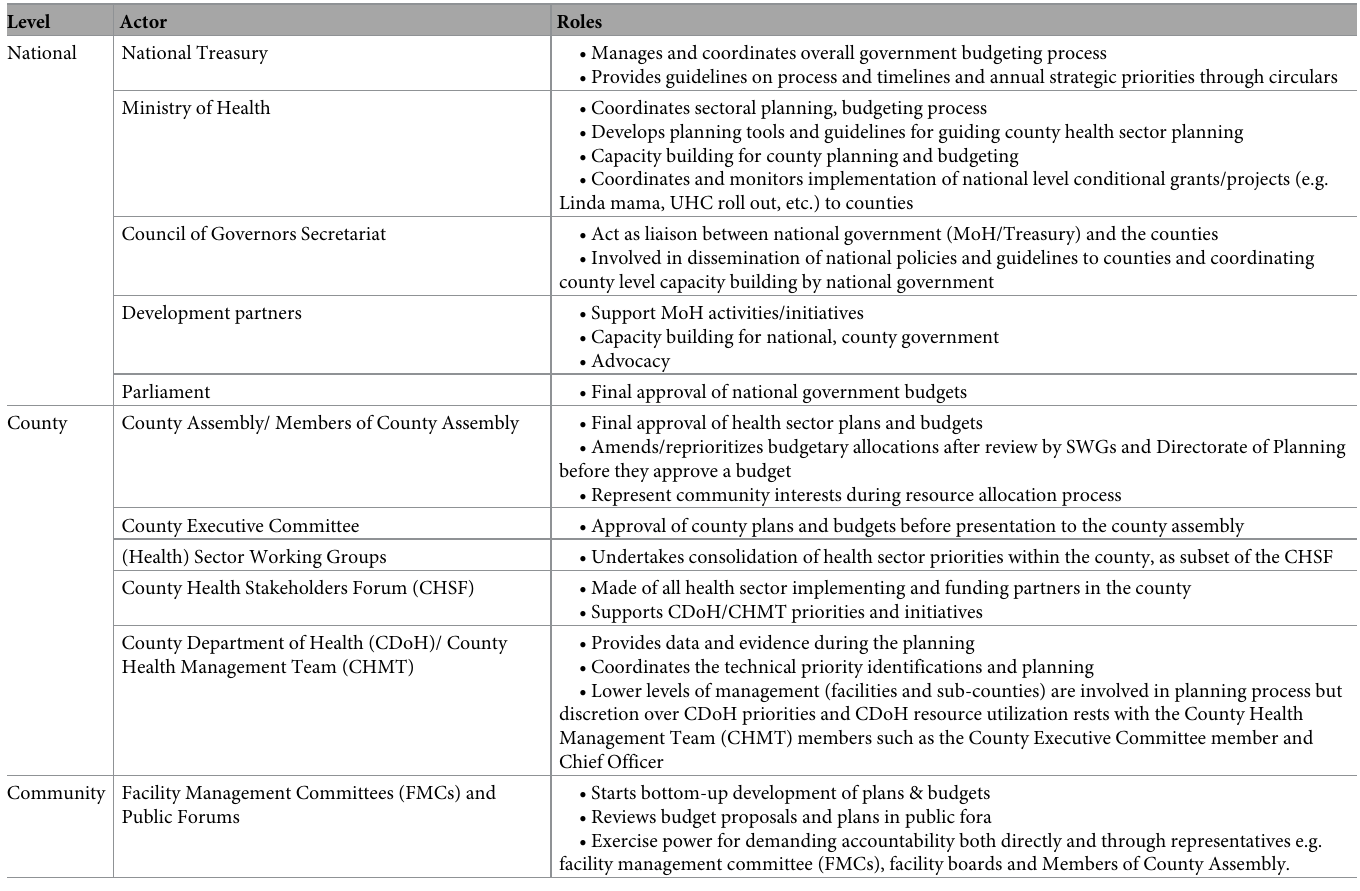
Table 3. Actors involved in national and sub-national health